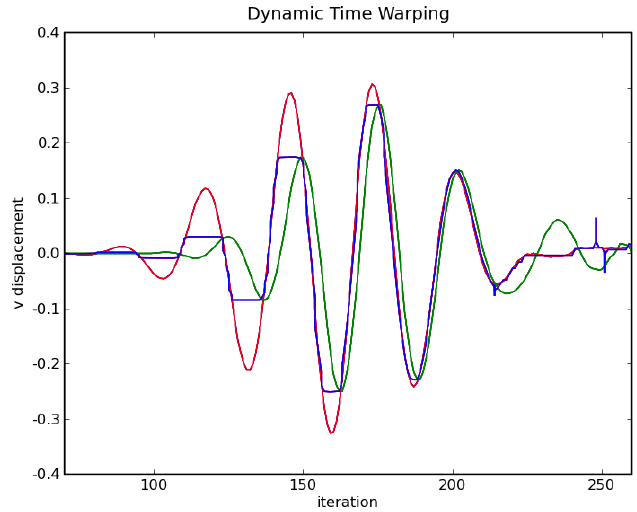
Fig. 5. Example showing the use of dynamic time warping for Lamb wave response